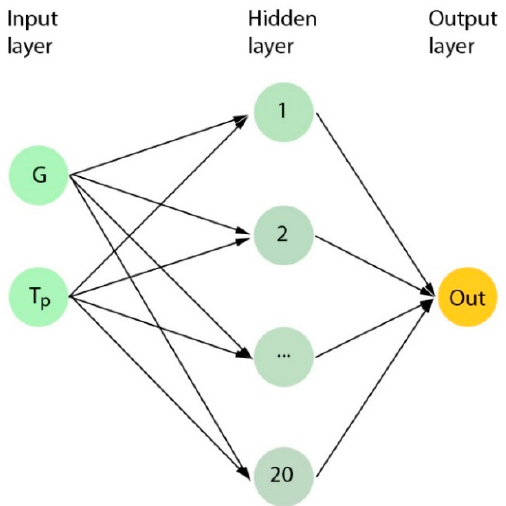
Figure 1. Structure of the feed-forward artificial neural network with one hidden layer of 20 nodes, employed in the data processing.